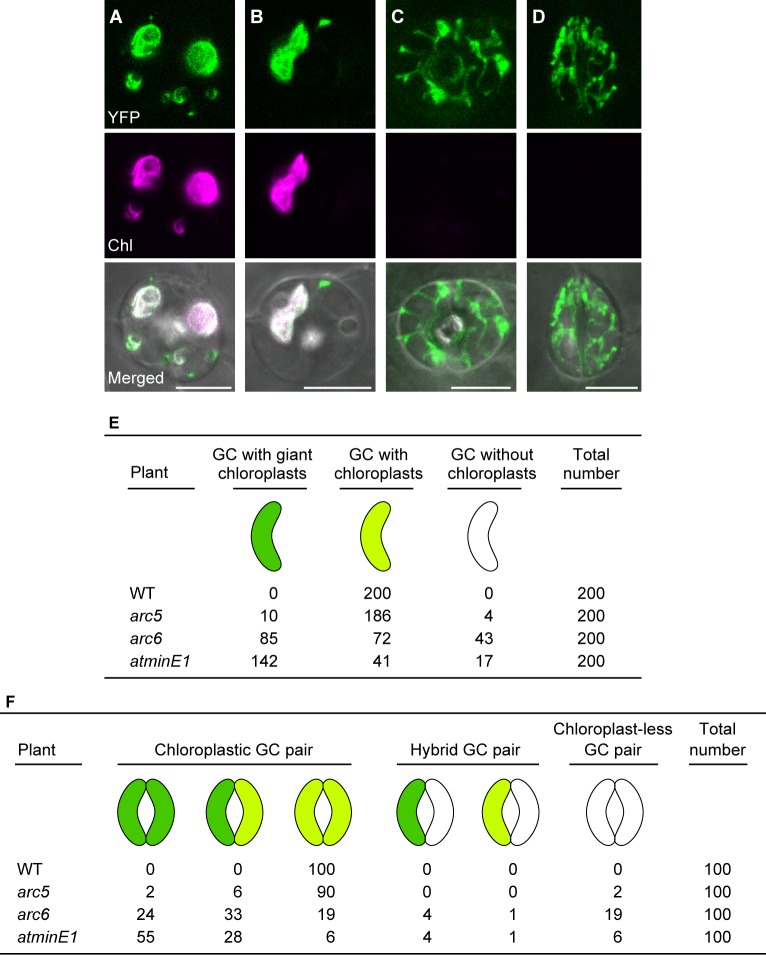
Classification of leaf stomatal GCs in Arabidopsis WT, arc5, arc6, and atminE1.(A–D) Images of stomatal GCs in the third-fourth leaf petioles of 4-week-old atminE1 seedlings. CLSM images of maximal intensity projection for plastid-targeted YFP (top panels) and chlorophyll autofluorescence (Chl; middle panels) and merged images with DIC (bottom panels) are shown. Bar = 10 μm. (E, F) Frequency of GCs with giant or normal-sized chloroplasts or lacking chloroplasts. In (E, F), the frequency of GCs in individuals (E) or paired cells (F) was counted in arbitrarily selected cells in the WT, arc5, arc6, and atminE1.